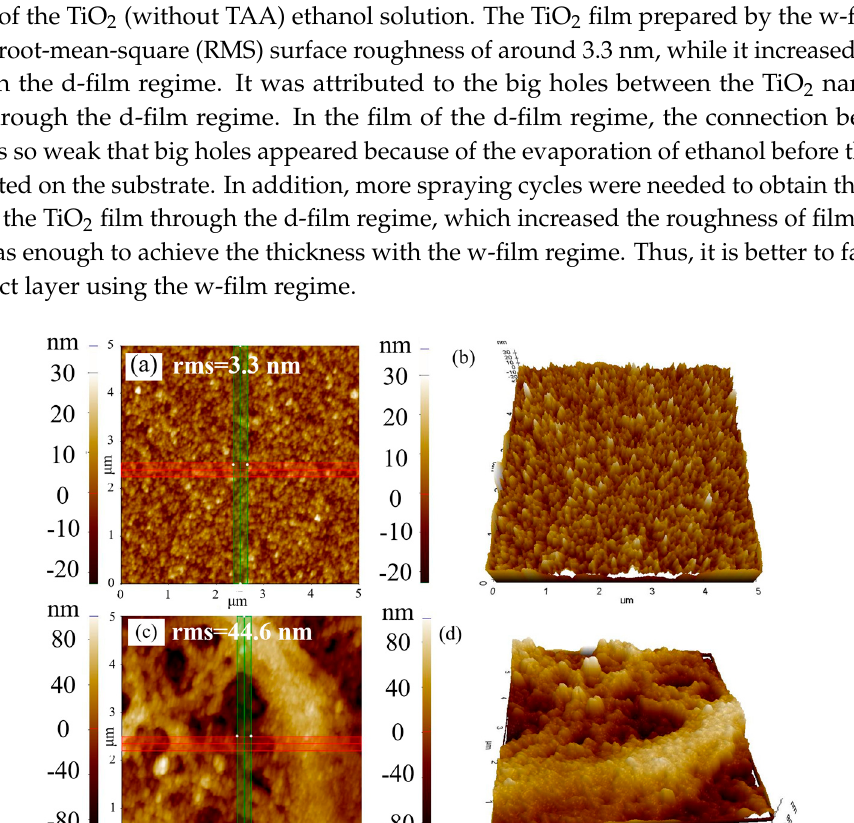
Table 1. The performance of devices fabricated based on the w-film ultrasonically sprayed TiO 2 with different thicknesses tuned by the concentration of TiO 2 dispersion .